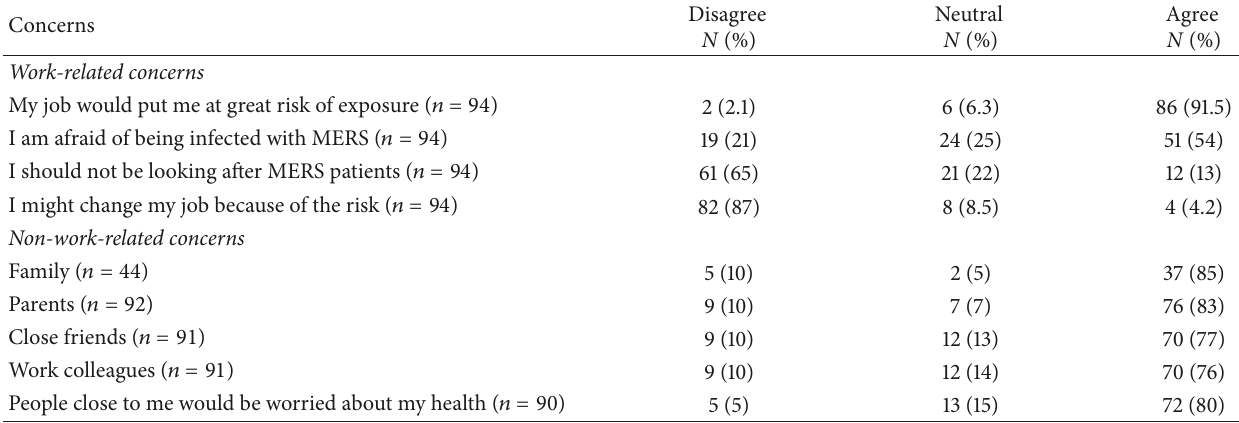
Table 2: Work- and non-work-related concerns of emergency room resident physicians regarding Middle East respiratory syndrome. Concerns Work-related concerns